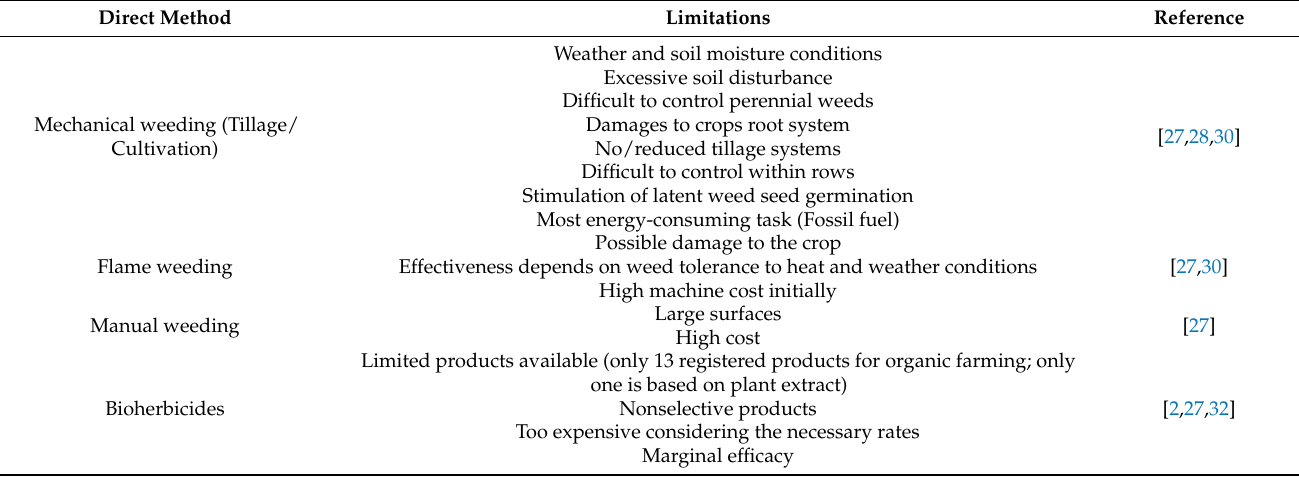
Table 1. Limitations to current direct weed control methods in organic farming. Direct